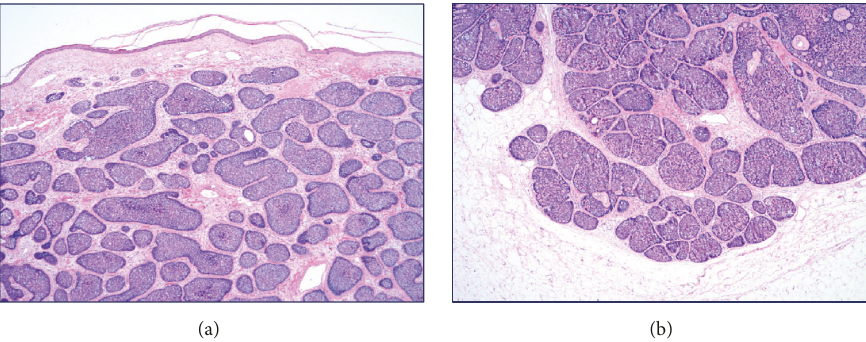
Figure 2: Histopathologic findings: (a) low magnification of skin surface showing intact, thinned epidermis with narrow grenz zone of uninvolved papillary dermis and subjacent epithelial proliferation of basaloid lesional cell nests arranged in a “jigsaw pattern,” H&E stain, 40x; (b) low magnification of deep edge of tumor with basaloid nests pushing into subcutaneous adipose tissue, H&E stain, 40x.